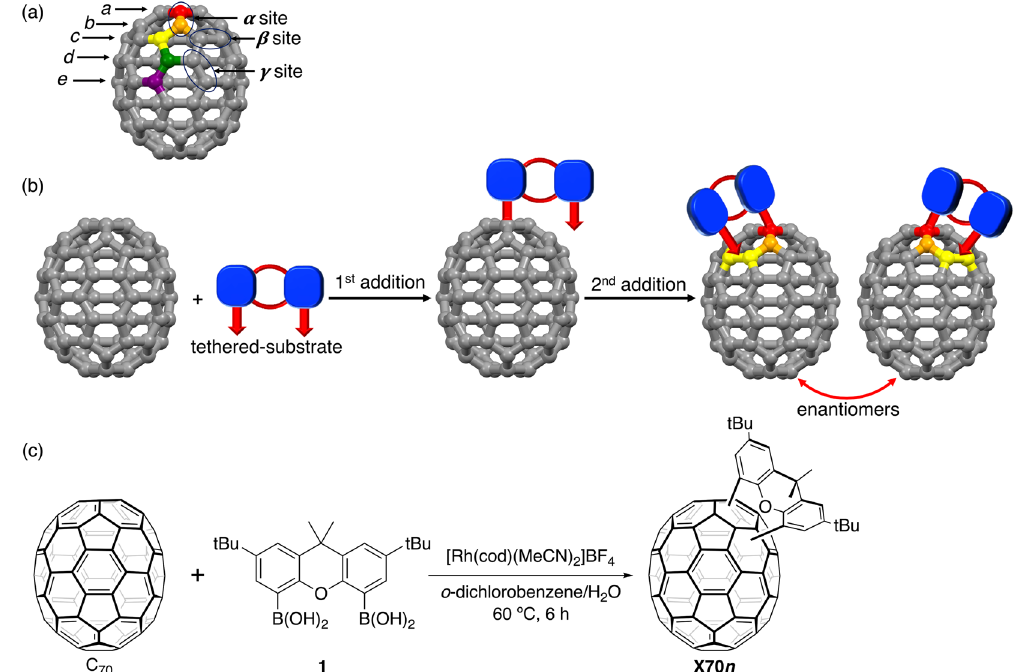
Figure 1. Schematic representation of the short distance tether-directed remote functionalisation of C 70 . ( a ) Ball-and-stick model of C 70 with carbon labels: a (red), b (orange), c (yellow), d (green), and e (purple). ( b ) Sequential reaction of the tethered-substrate with C 70 , which is bound to carbon a in the first addition reaction. Here, the second addition reaction is limited to the β site. The reaction leads to chiral racemic products given the equivalence of the β sites on the two sides adjacent to the α site. ( c ) Reaction of C 70 with bis-borylated xanthene 1 to afford X70 n . cod =